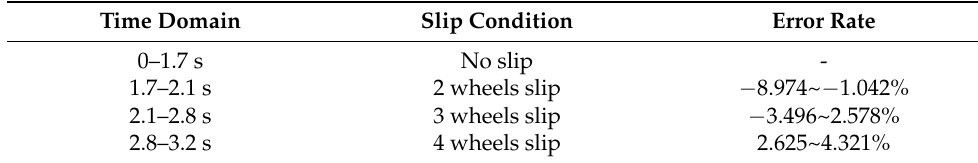
Table 3. Experimental